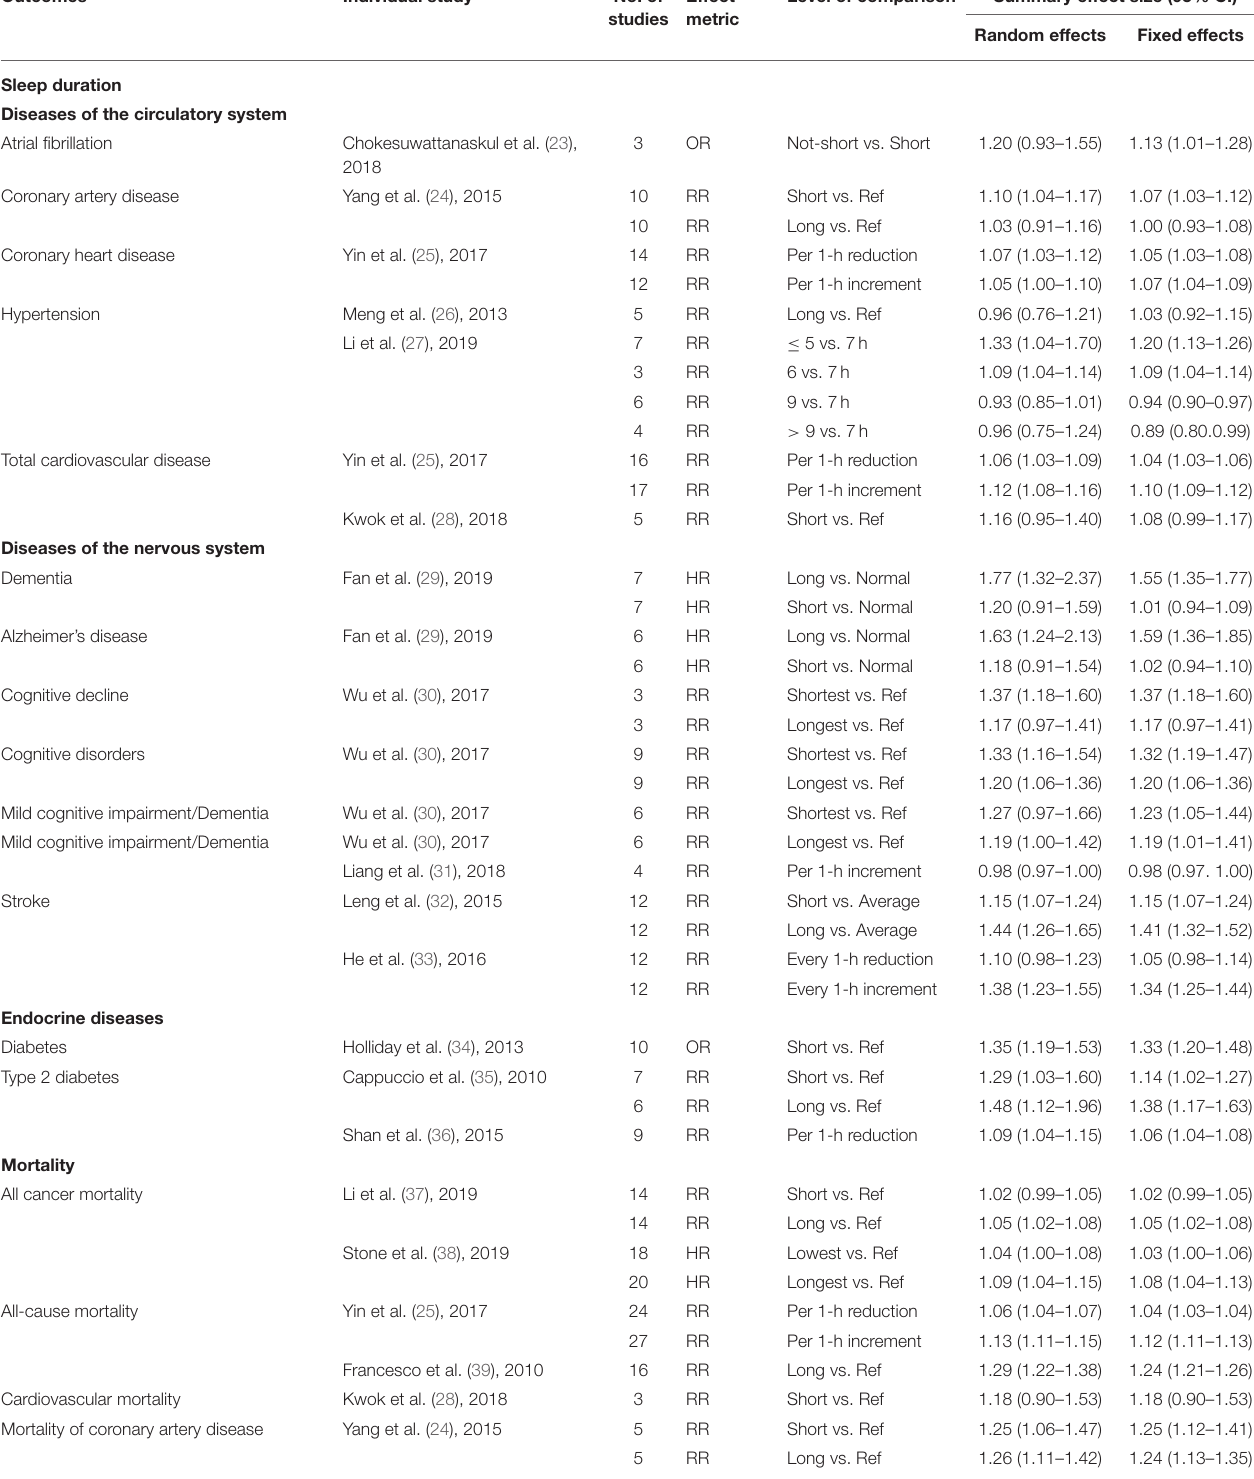
TABLE 1 | Main characteristics of included systematic reviews or meta-analyses that evaluate sleep duration/quality and health outcome